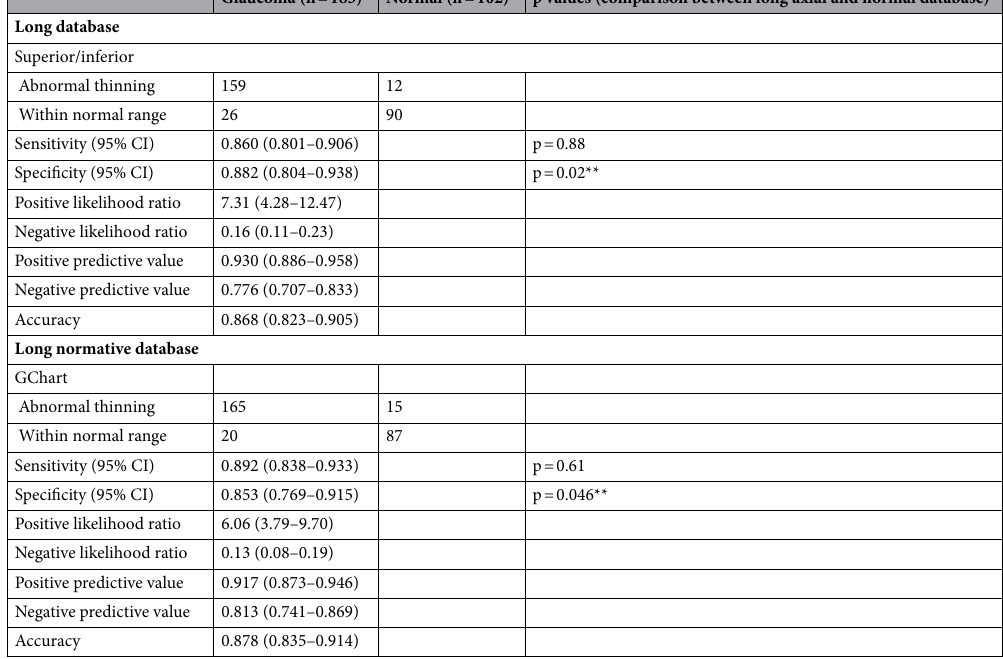
Table 5. Discriminating ability of the long axial database on macular ganglion cell complex thickness for glaucoma detection. CI Confidence Interval. **Statistical significance shown at p <